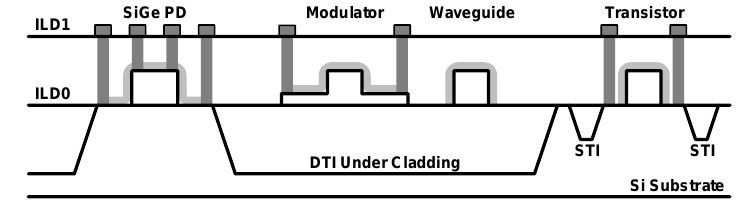
Figure 9. Cross-section of photonic and electronic devices [49].